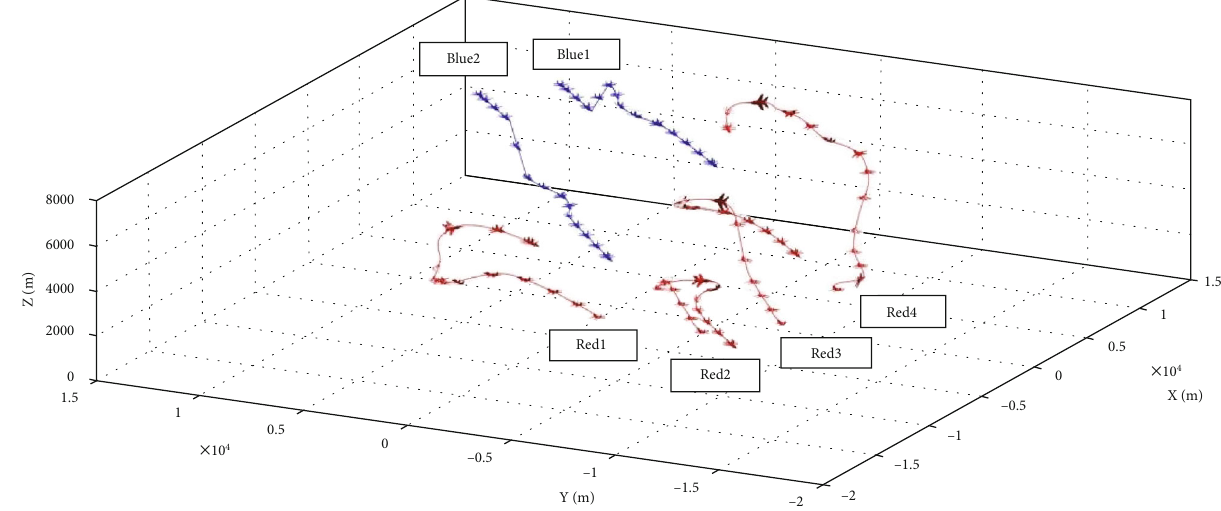
Figure 7: Air-combat simulation trajectory. The red side has four fi ghters, and the blue side has two.